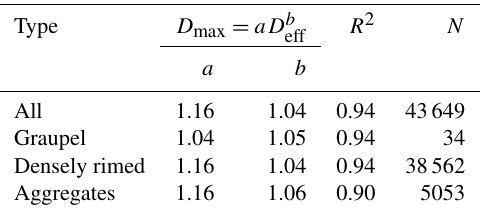
Table 1. Relationships between hydrometeor circumscribed and ef- fective diameter.